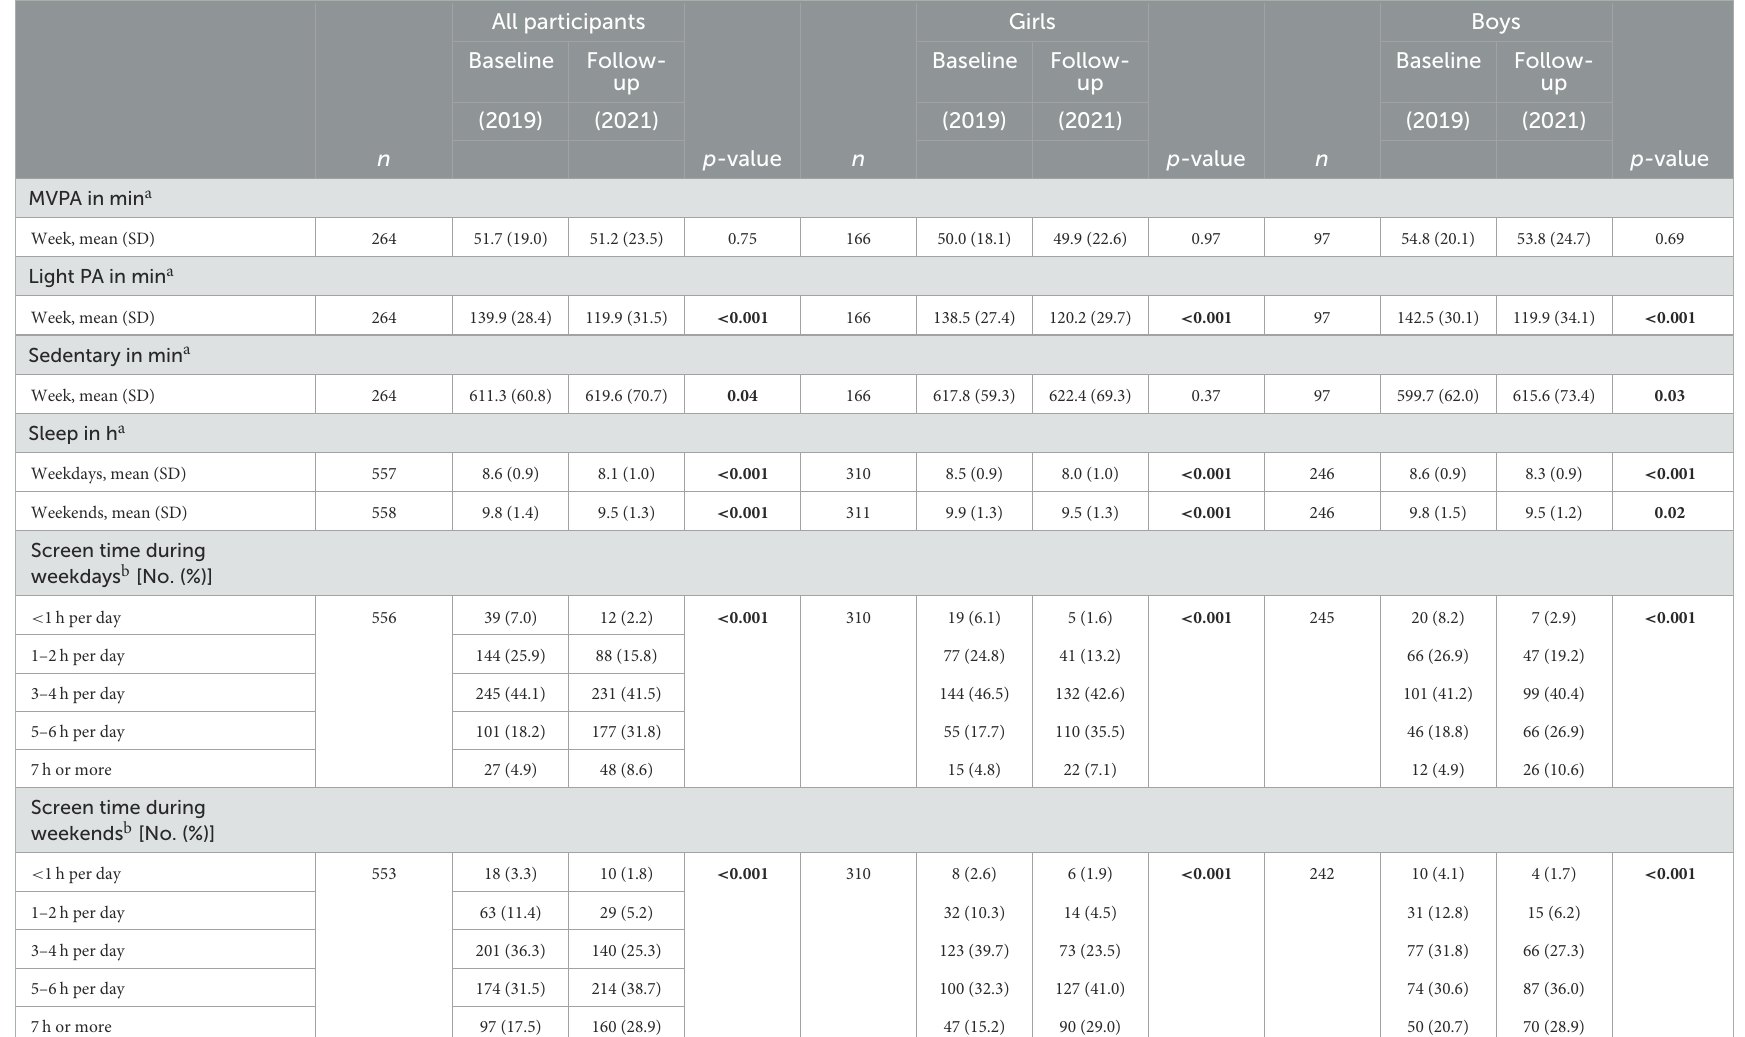
TABLE 3 Baseline and follow-up data for physical activity, sedentary time, and health behaviors, stratified by gender.